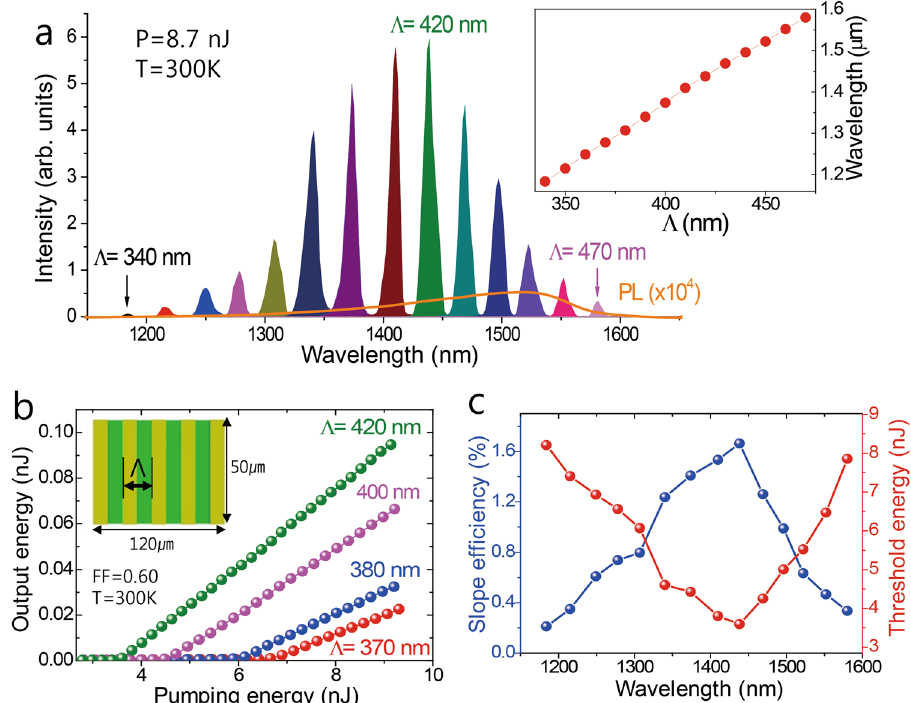
Figure 3. Emission wavelength tunability. ( a ) Lasing spectra for different slit periods Λ at a constant pump energy of 8.7 nJ. The peak positions are presented in the inset as a function of the period. ( b ) Output versus pumping energy curves obtained from gratings with different periods. ( c ) Lasing efficiencies (blue), defined as the linear slope of the output energy with respect to the pump energy, and threshold energies (red) for different slit periods, shown as a function of lasing